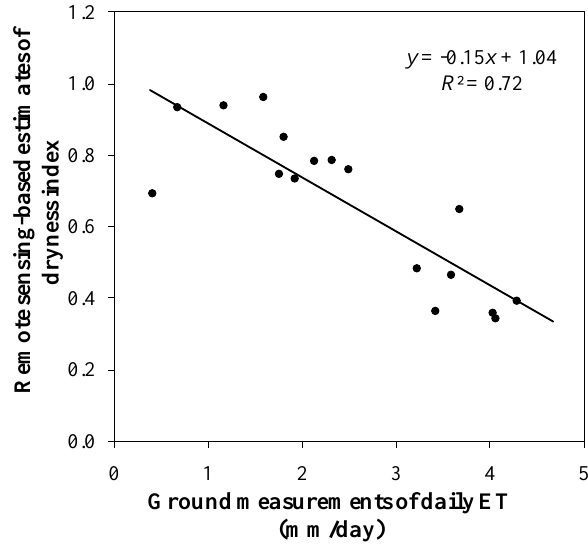
y = -0.15 x + 1.04 R ² = 0.72